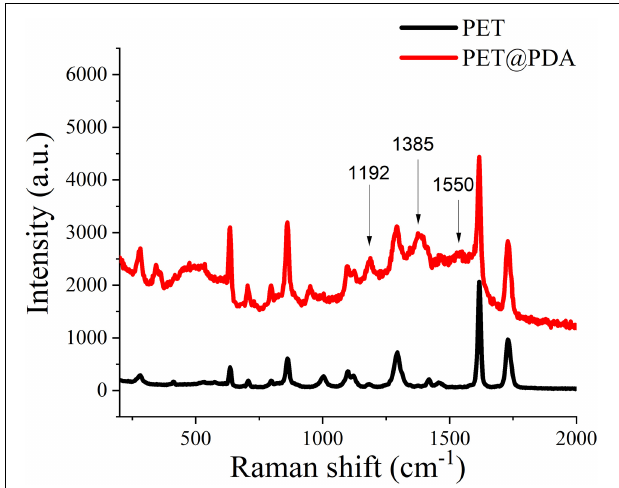
FIGURE 3 | Raman spectrum of PET artificial ligament (black) and PDA-modified PET artificial ligament